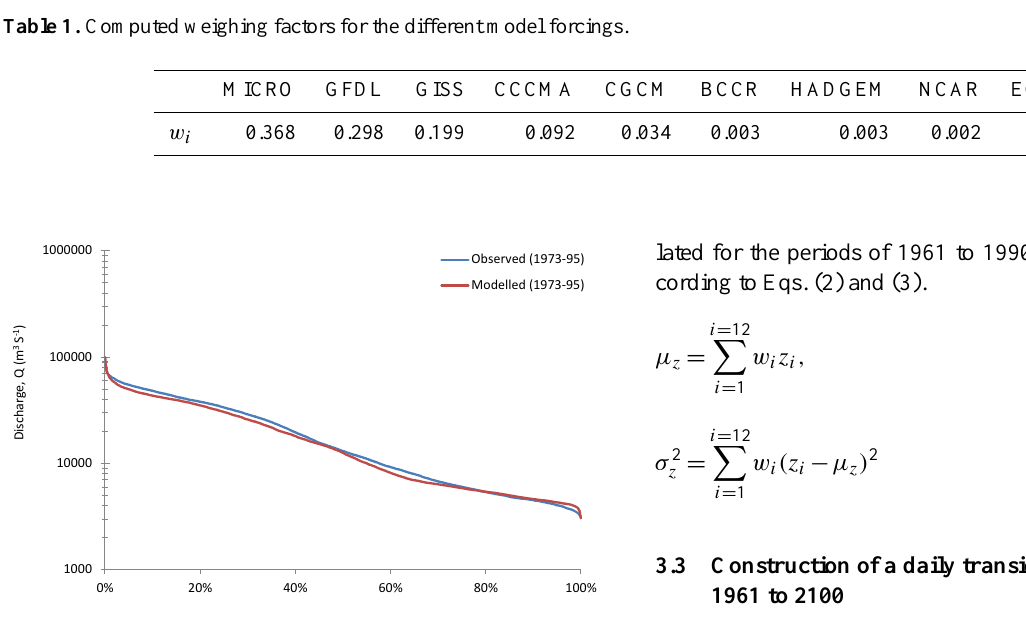
Fig. 3. Comparison of flow duration curve between observed and discharge weighted modelled data for the period